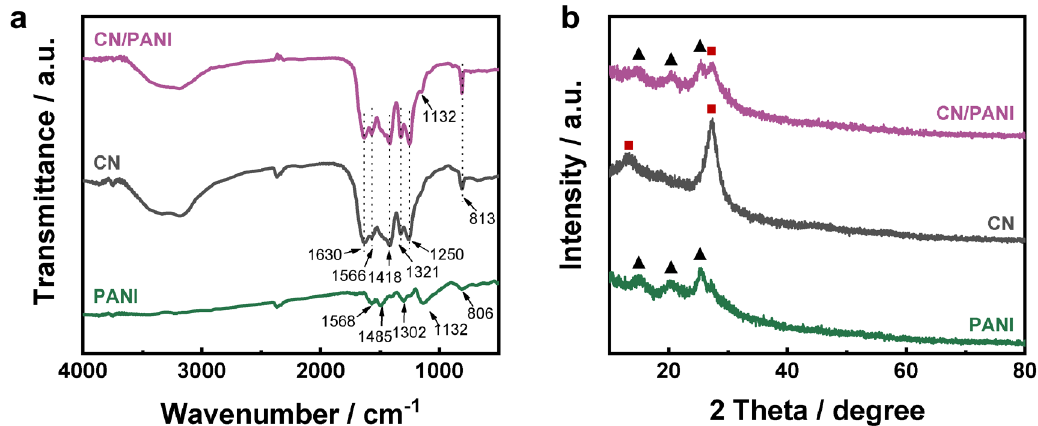
Figure 2. ( a ) FTIR spectra and ( b ) XRD patterns of pristine CN, PANI, and CN/PANI heterojunction film.